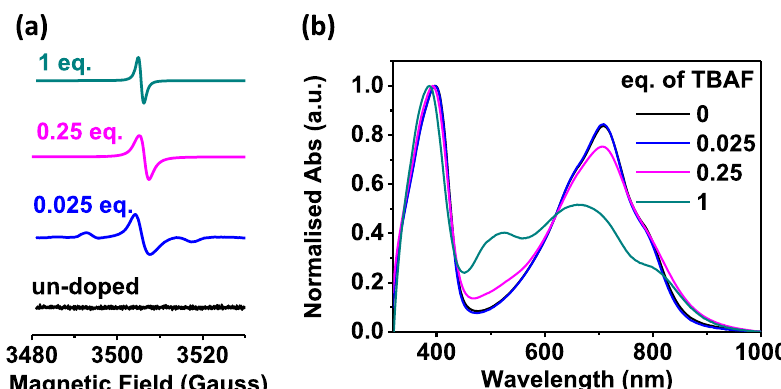
Fig. 2 a EPR and b UV – Vis absorption spectra of un-doped and doped polymer fi lms with representative dopant